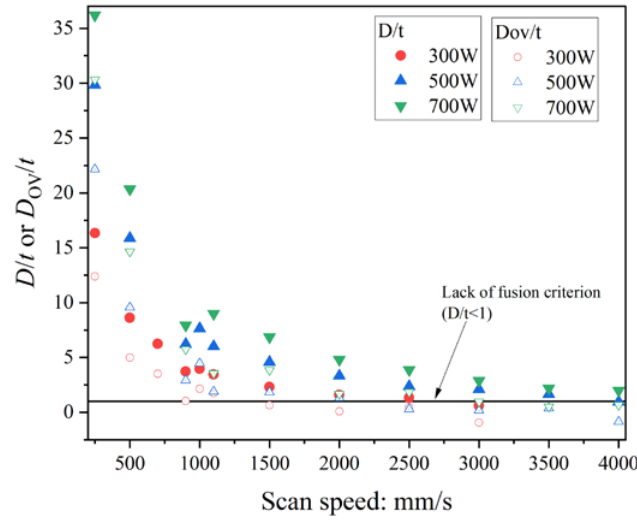
Figure 10. The D / t and D ov / t estimated assuming that h = 100 μm for the single-track experiments.